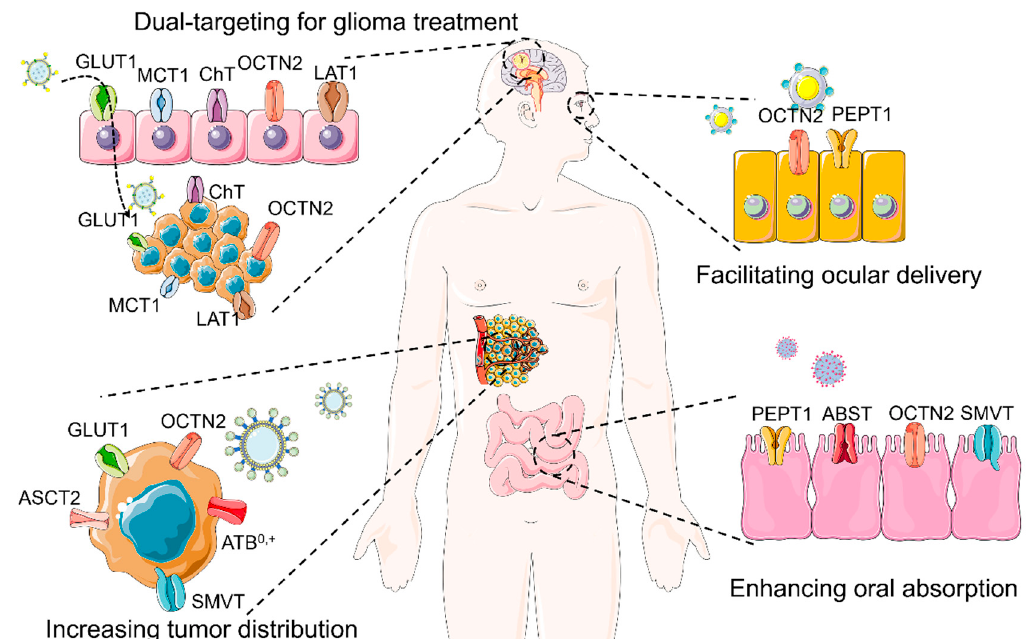
Figure 1. Transporter-targeted nano-drug delivery systems for enhanced and site-specific drug delivery. GLUT1, facilitative glucose transporter-1 (SLC2A1); MCT1, monocarboxylate transporter-1 (SLC16A1); ChT, choline transporter (SLC5A7); OCTN2, novel organic cation transporter-1 or organic cation / carnitine transporter (SLC22A5); LAT1, L-amino acid transporter-1 (SLC7A5); ASCT2, Alanine-Serine-Cysteine Transporter-1 (SLC1A5); SMVT, sodium-coupled multivitamin